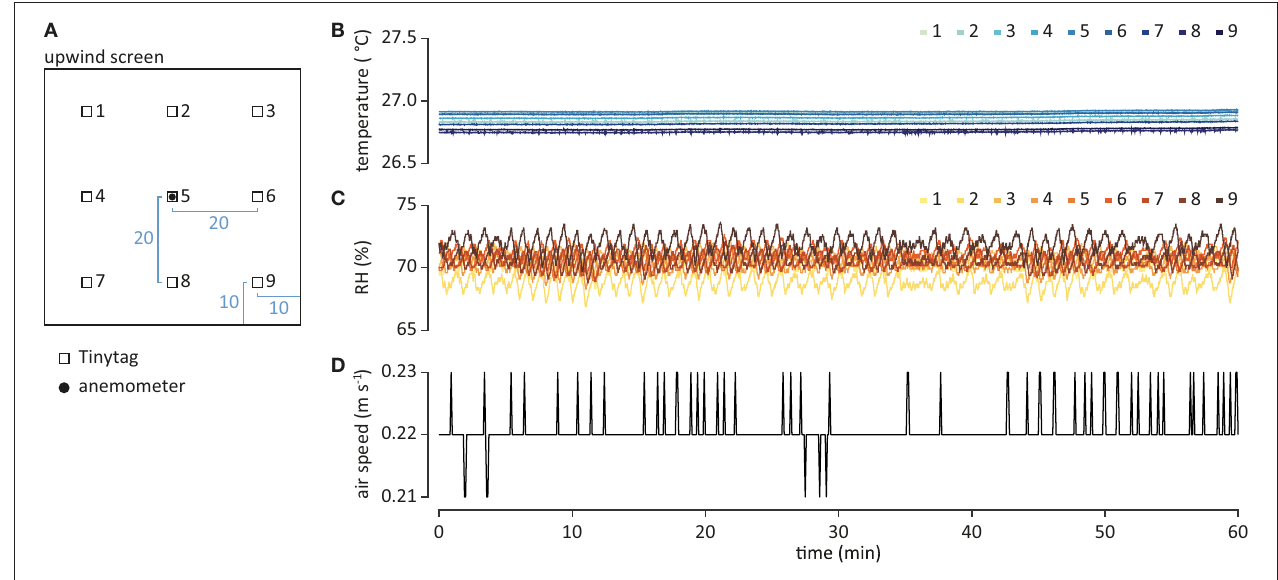
FIGURE 2 | Physical parameters of the wind tunnel system. (A) Schematic of the placement of the Tinytags (open square), for measurement of temperature and relative humidity (RH), and anemometer (filled circle), for wind speed, at the upwind screen. Measurements in cm. The distance to the upwind screen was 15cm. Temperature (B) , RH (C), and air speed (D) over time.